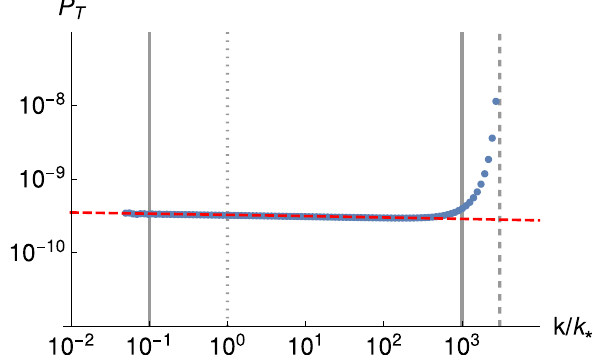
Fig. 3 Comparisonofthetensorpowerspectrum P T :theclassicalpre- diction obtained from ω cl ( k ) = k (red dashed curve) and the prediction obtained from modified dispersion relation ω( k ) (blue dots). In both cases, the mode equation has been solved numerically with initial con- ditions(36)at η o correspondingto N = 62 . 45e-folds,whichisachieved by a scalar field with mass m = 1 . 3 × 10 − 6 and value φ(η o ) = 3 . 13 = 0) – all quantities expressed at the beginning of inflation ( d φ/ dt | η o in Planck units. For the modified case, the choices (cid:2) = 0 . 015 and β = 0 . 2375 have been made. The vertical solid lines denote the observ- able region k ∈ k ∗ [ 10 − 1 , 10 3 ] (with k ∗ the pivot mode corresponding to 0 . 002 Mpc − 1 today), while the dashed one is the maximum propagating mode k o , according to equation